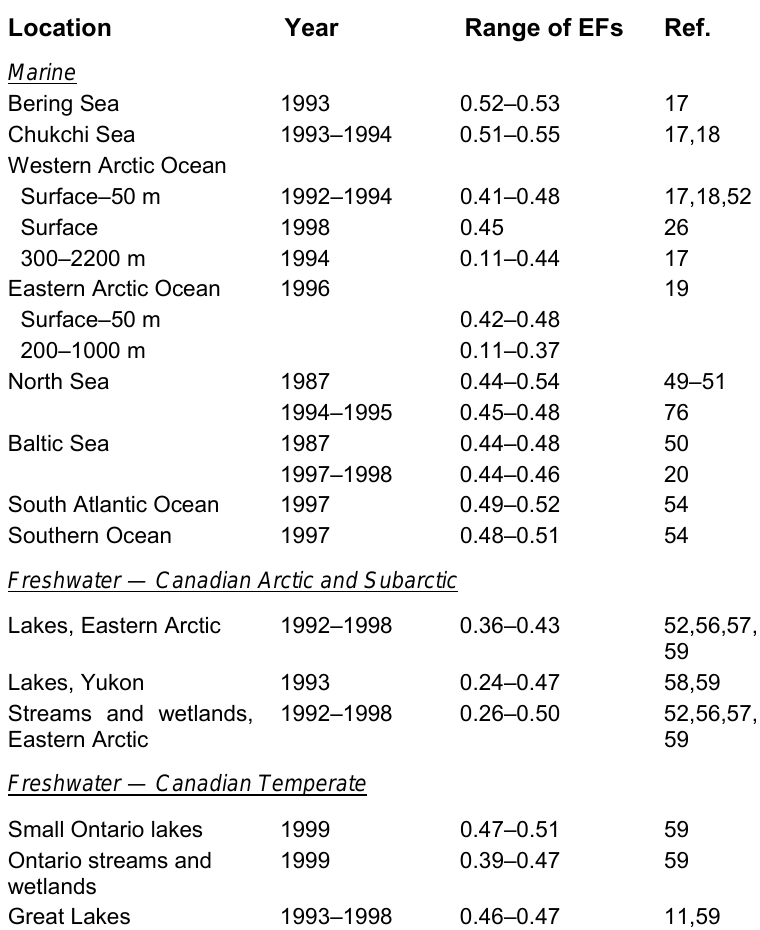
Enantioselective Degradation of α -HCH in Oceans and Lakes